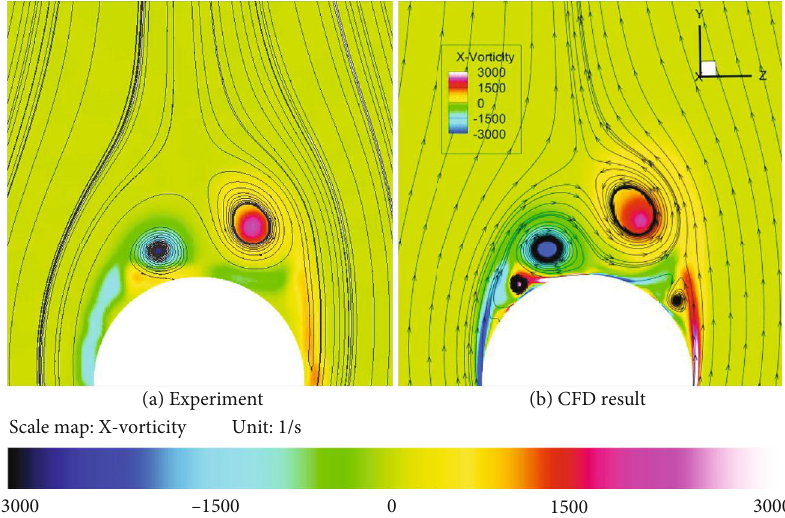
Figure 16: Comparison contour of experimental and numerical simulation results for surface roughness R a = 0 : 8 μ m at section 2.